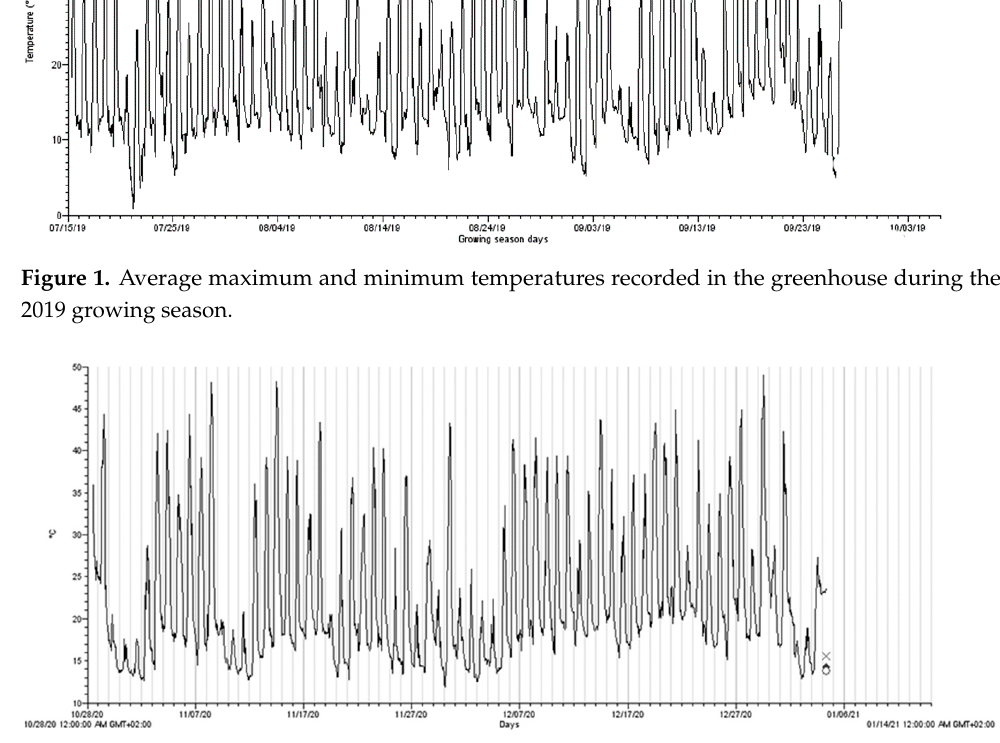
Figure 2. Average maximum and minimum temperatures recorded in the greenhouse during the 2020 growing season. Table 2. Summarised meteorological conditions for the respective growing seasons (S i